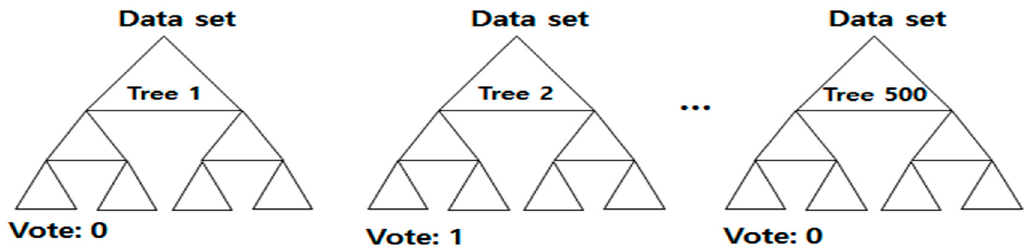
Figure 1. Conceptual diagram of random forest model.